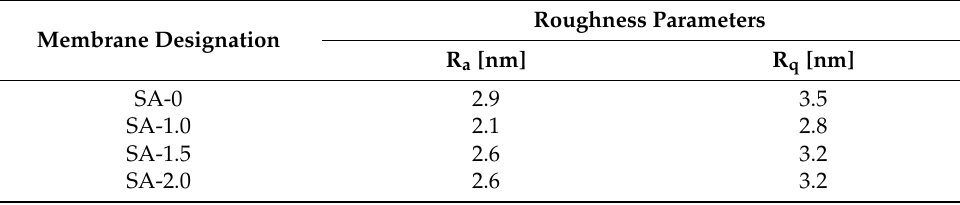
Table 4. The surface roughness parameters of the reference PSF/Synperonic F108 and PSF/Synperonic F108/PAA